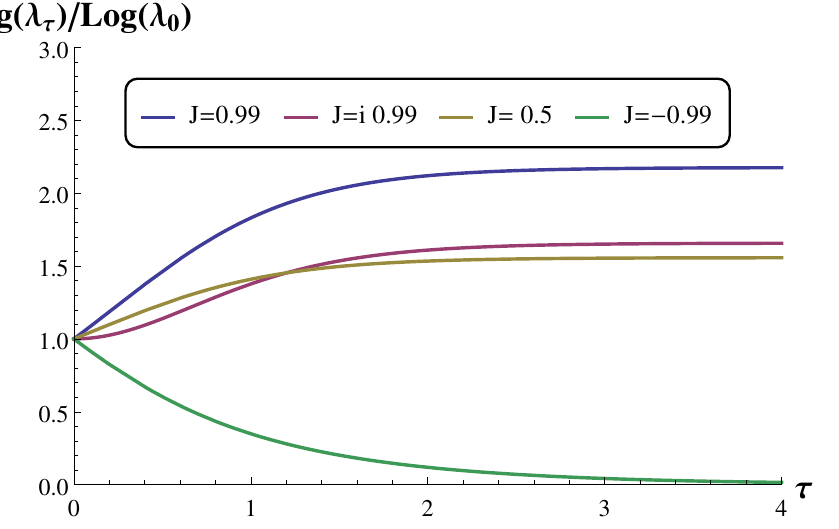
Figure 2 . The curves of (cid:12)xed J in (2.17) as a function of (cid:28) . We see from the intersection at